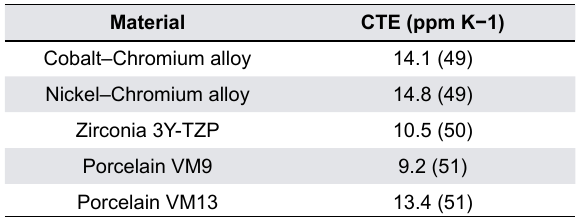
Table 2- CTE values of material framework and ceramics